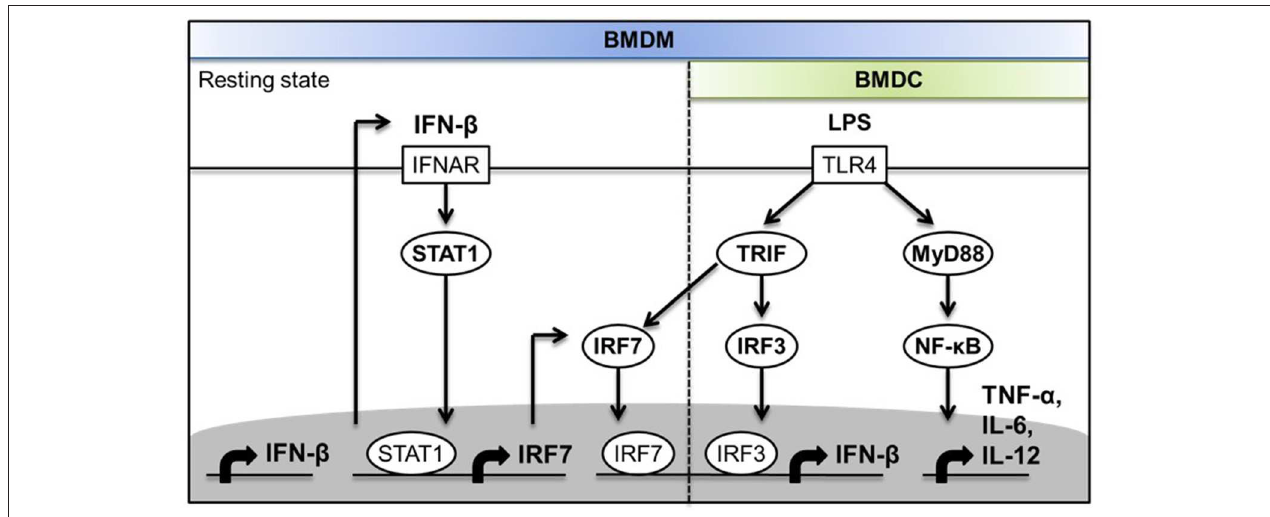
FIGURE 8 | Schematic diagram depicting the molecular mechanisms of the involvement of IRF-7 in TLR4-induced IFN- β expression in macrophages but not in